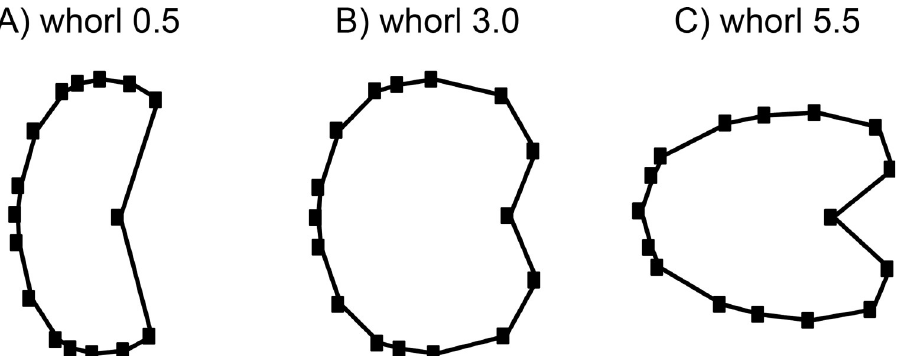
Fig 5. Mean shapes of whorl stages. (A) Whorl stage 0.5, (B) whorl stage 3.0 and (C) whorl stage 5.5.